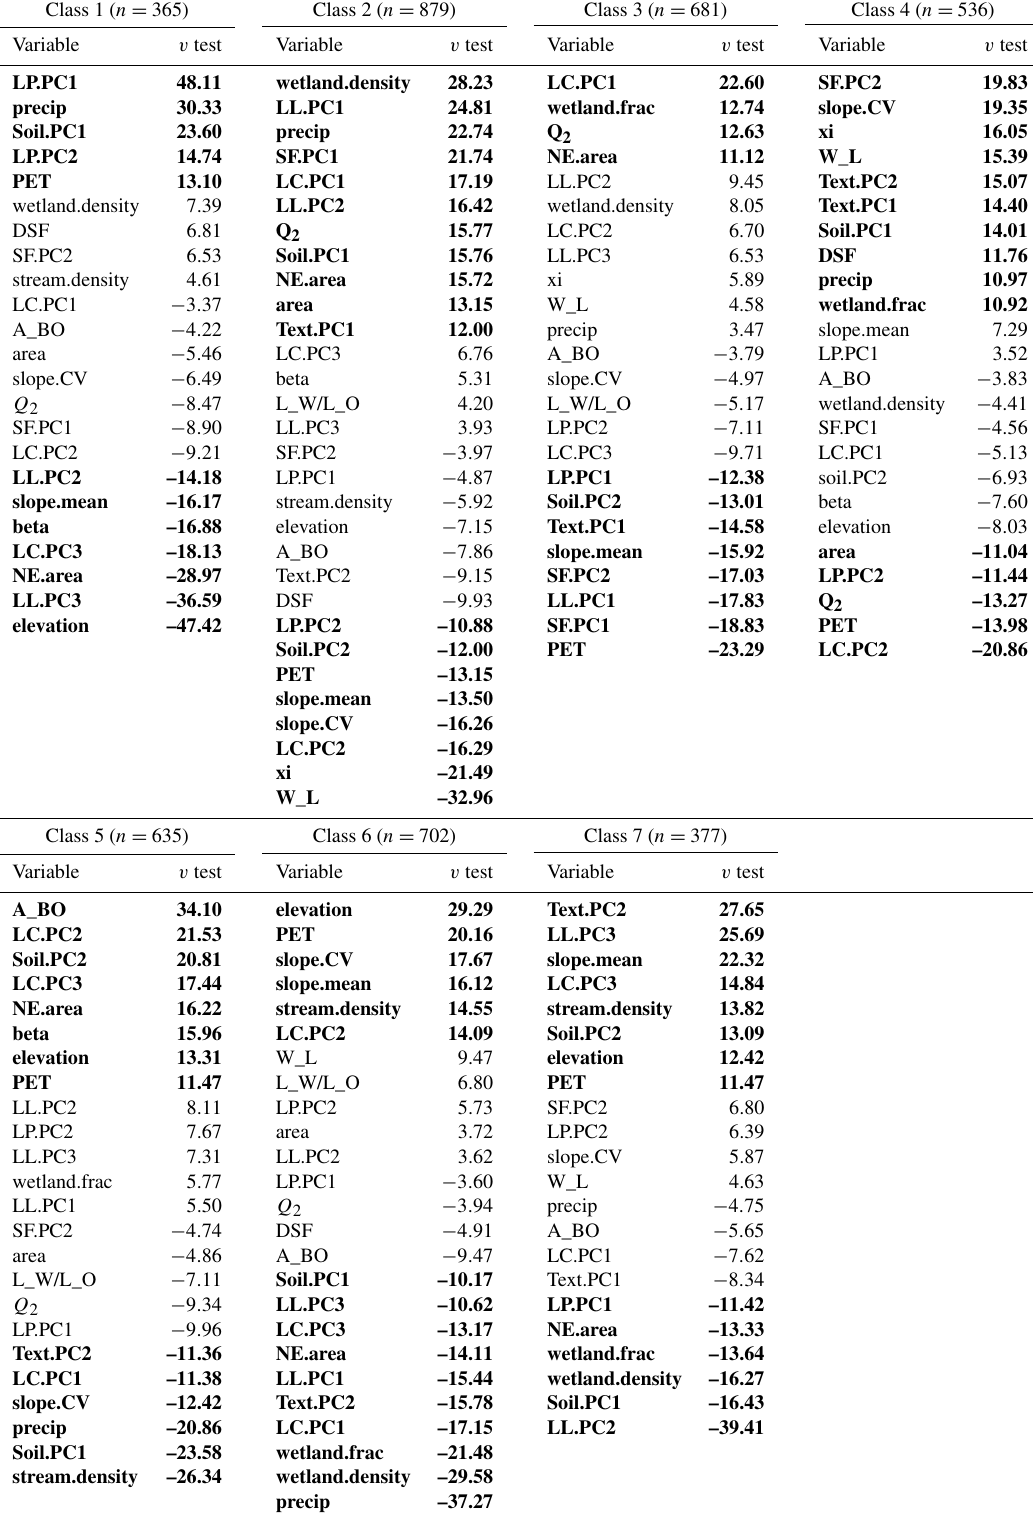
Table 4. Classes and distinguishing variables of Prairie watersheds. The v -test statistics, based on Ward’s criterion, are shown. Variables with v -test values greater or less than 10 and − 10, respectively, are bolded to emphasize defining features of each class. All variables are significant to p < 0 . 001. Classes: Southern Manitoba (1), Pothole Till (2), Pothole Glaciolacustrine (3), Major River Valleys (4), Interior Grasslands (5), High Elevation Grasslands (6), Sloped Incised